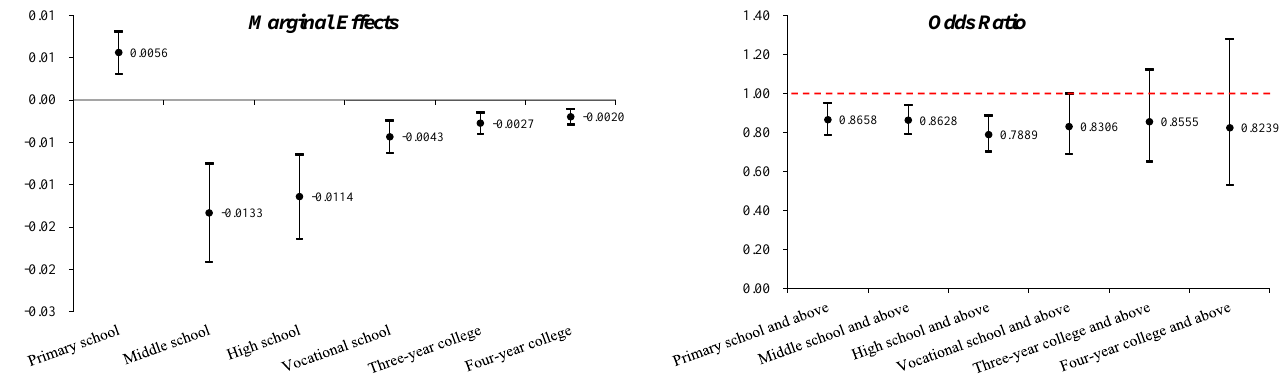
Figure 3. Marginal effect and probability ratio of education level on domestic violence index. Table 4. Interpreted, explanatory and control variables.